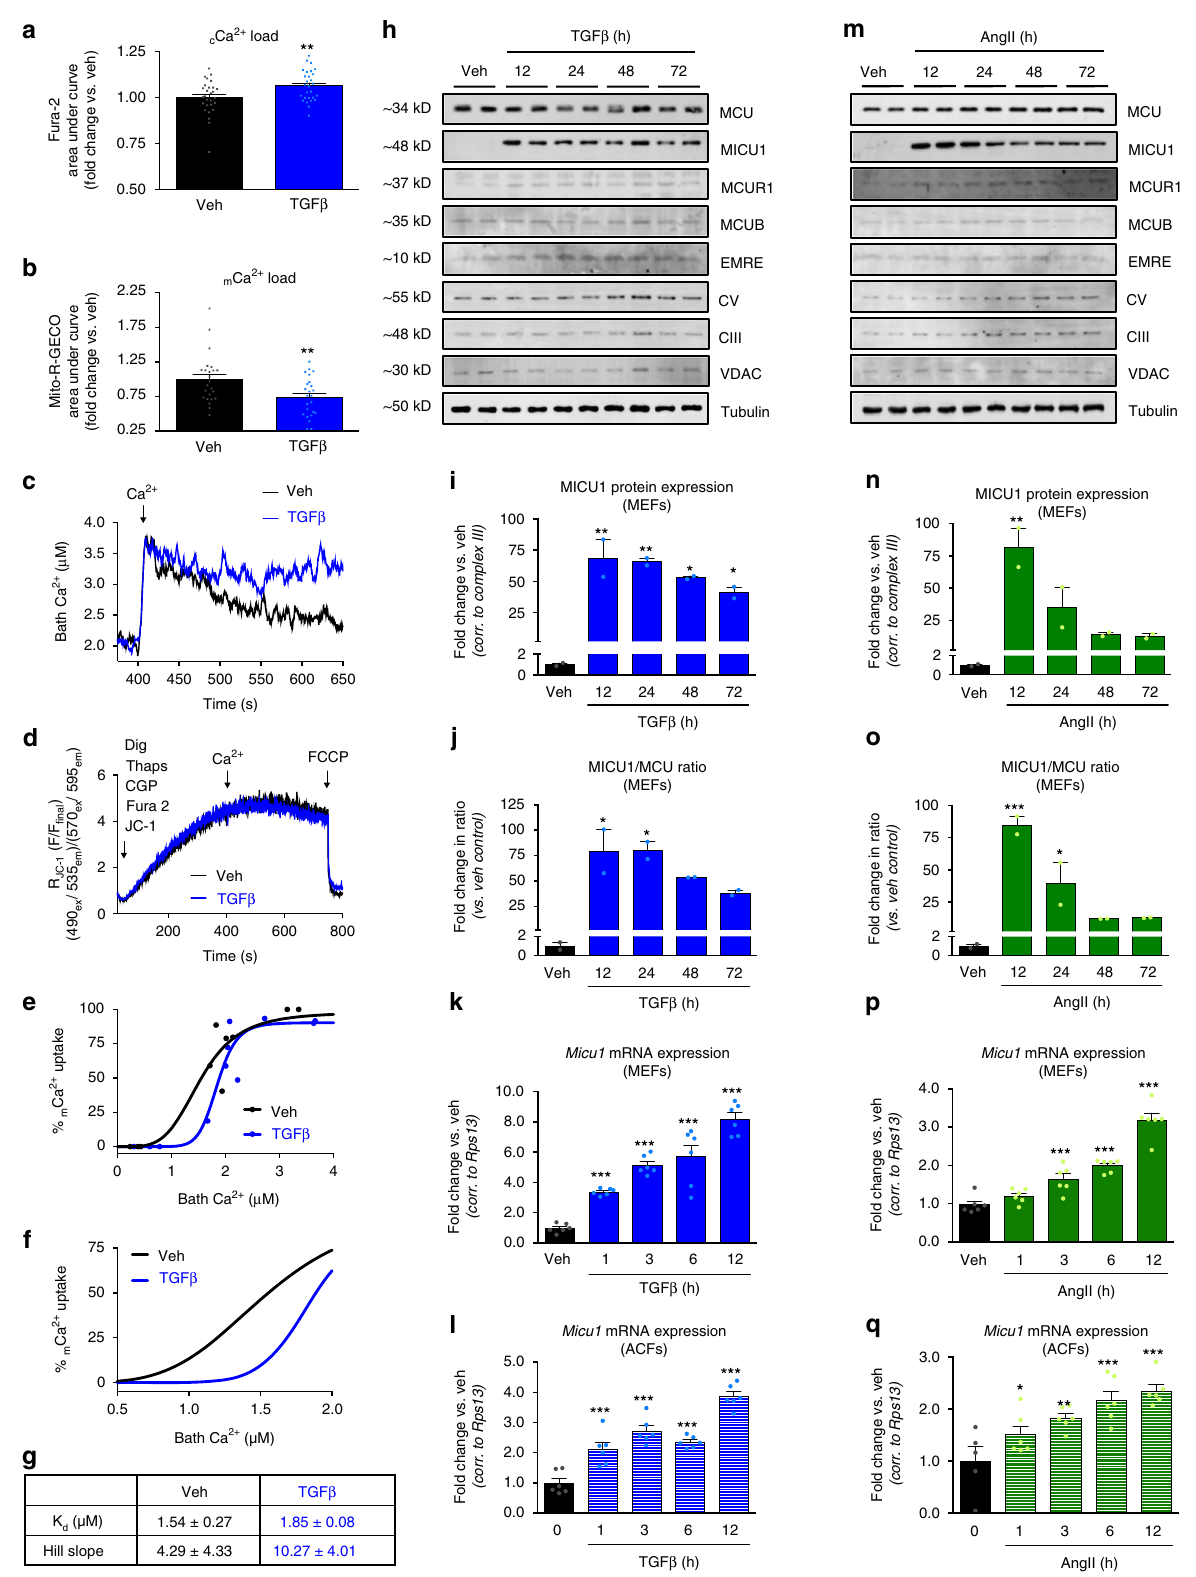
later treated with TGF β or AngII for 24 h followed by quanti fi cation of α -SMA + cells by immuno fl uorescence. Enhan- cing glycolysis was suf fi cient to drive myo fi broblast formation (Fig. 3q, r) and potentiated cellular differentiation elicited by